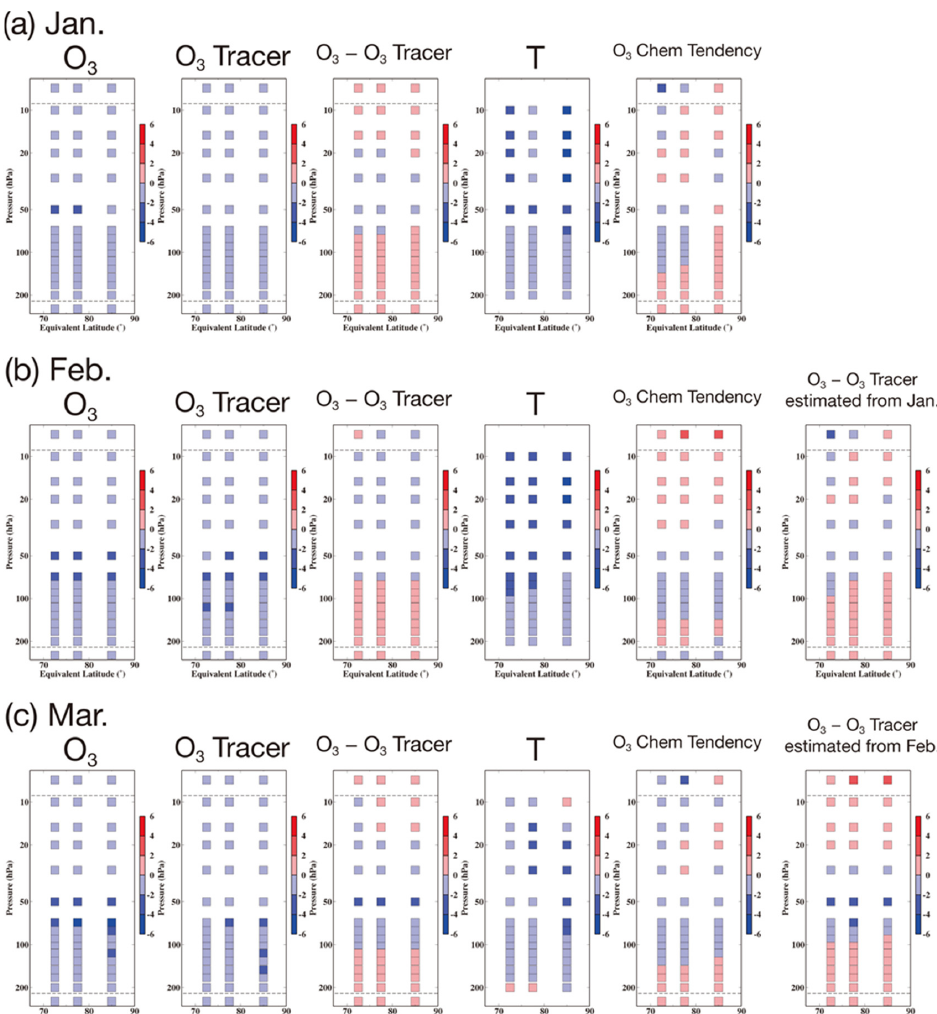
Figure 8. ( a ) Equivalent latitude–height section of the partial column ozone anomaly in January (upper left panel) for the QBO-W/S min years from the REF-C1SD experiment. The interval for the color scale is 2 DU. The colored squares above 10 hPa and below 200 hPa indicate the column values above 10 hPa and below 200 hPa, respectively. The 2nd and 3rd panels from the left display the partial column anomaly of the passive ozone tracer and the difference between the ozone anomaly and the anomaly of the passive ozone tracer, respectively. The 4th panel displays the temperature anomaly expressed in the 2 K interval for the color scale, and the 5th panel displays the monthly mean partial column anomaly of the chemical tendency of ozone in units of DU/month with an interval of 2 DU/month for the color scale. ( b ) Same as ( a ) but for February. The 6th panel displays the anomalies estimated by the sum of the monthly mean chemical tendency in January and the difference between the ozone anomaly and the anomaly of the passive ozone tracer in January. ( c ) Same as ( a ) but for March. The 6th panel displays the anomalies estimated by the sum of the monthly mean chemical tendency in February and the difference between the ozone anomaly and the anomaly of the passive ozone tracer in February.